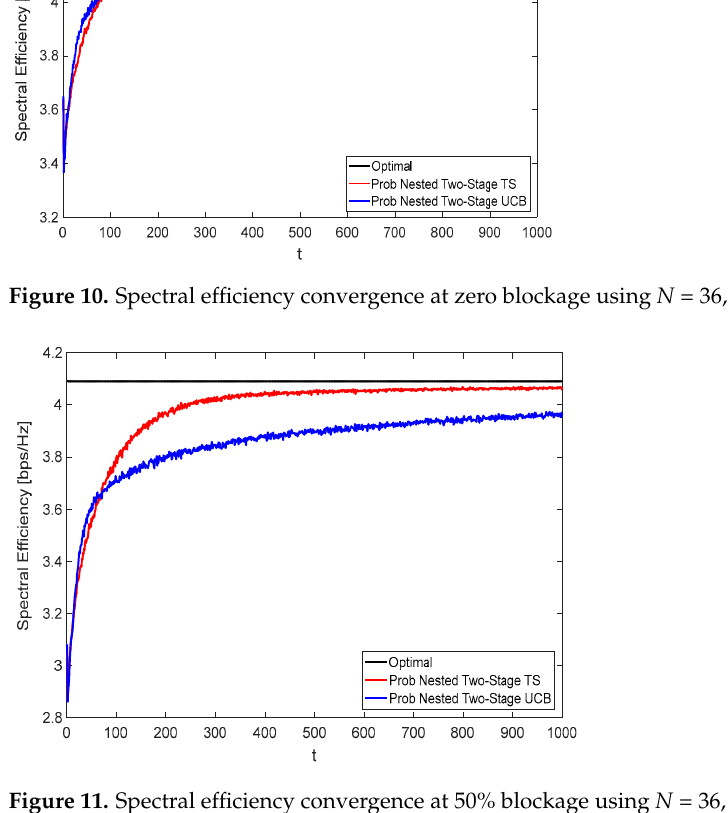
Figure 11. Spectral efficiency convergence at 50% blockage using N = 36, M = 64, and K = 16.